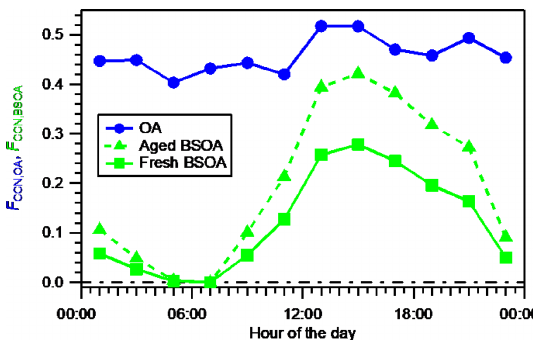
Figure 6. Diurnal variation in the fractional contribution of OA to the total CCN number concentration ( F CCN , OA ) estimated us- ing time- and size-resolved κ org , and diurnal variation in the frac- tional contribution of BSOA to the total CCN number concentration ( F CCN , BSOA ) estimated assuming fresh BSOA (using size-resolved κ BSOA ) and aged BSOA (using size-resolved κ ROA